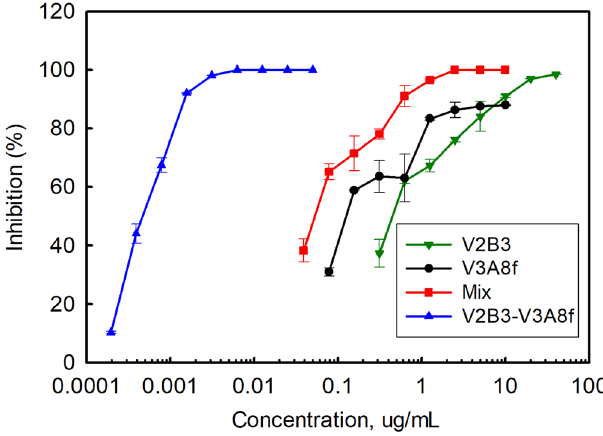
Figure 3. Representative PRNT data sets showing standard versus mixture versus linked sdAb. V2B3 and V3A8f are shown in green and black respectively. The mix of V2B3 and V3A8f is shown in red, and the linked V2B3-V3A8f is in blue. Each measurement was performed in duplicate, error bars represent the standard error.